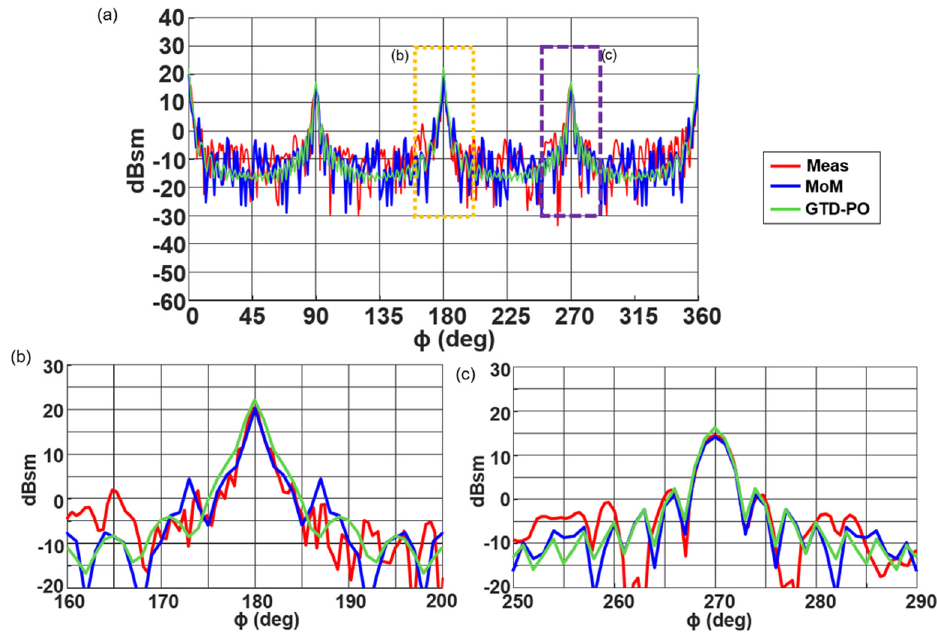
Figure 3. Metallic box. ( a ) Monostatic RCS results in near-field conditions (at 5.50 m): GTD–PO simulation, MoM simulation, and measurements. Detail of the RCS in the broad wall ( b ) and the narrow wall ( c ) of the metallic box.